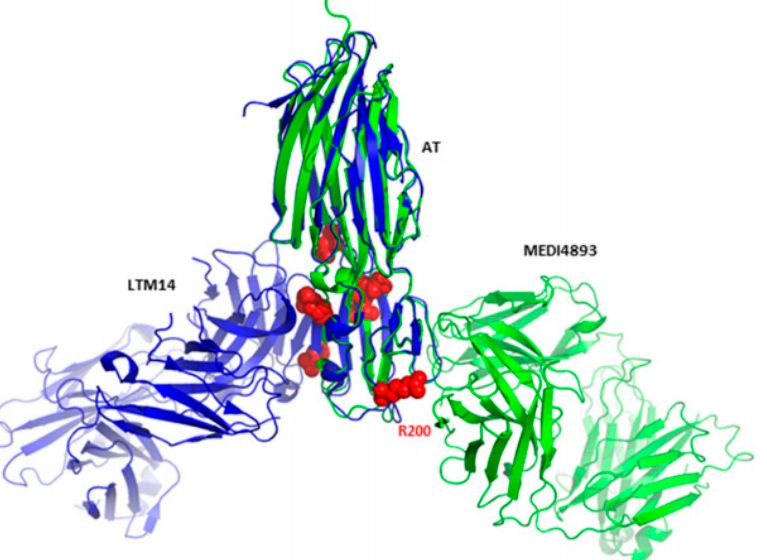
Figure 12. Superimposition of monomeric AT bound to MEDI4893 Fab (green) with monomeric AT bound to mAb LTM14 (PDB code 4IDJ, blue). Both Fab molecules bind to the same rim domain, though on opposite sides. Residues known to be critical for AT interaction with the cell surface receptor are shown as red spheres. Adapted from Oganesyan et al. [86].